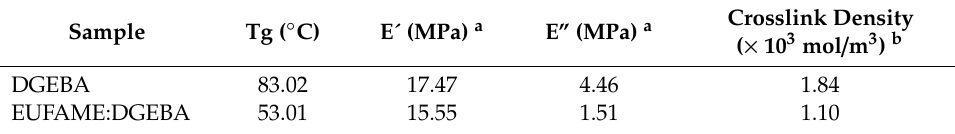
Table 6. DMA values for cured neat epoxy resin (DGEBA) and cured EUFAME / DGEBA